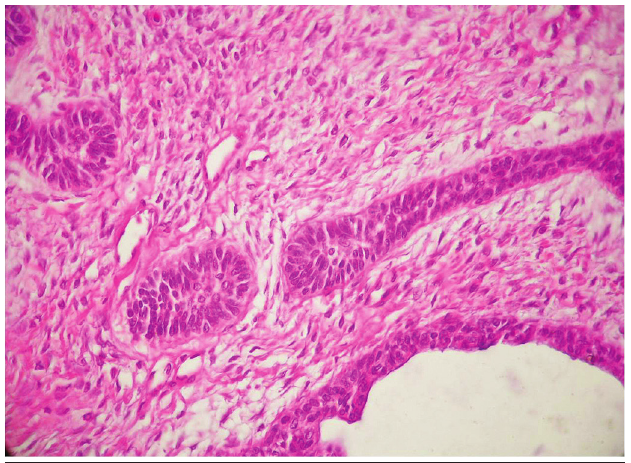
figurE 3 − Mixed epithelial and mesenchymal components (HE, 200×) HE: hematoxylin and eosin.